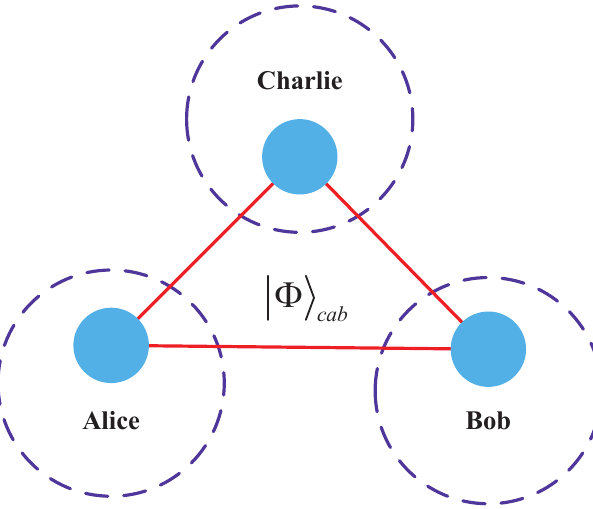
Figure 1. The diagram of scanning radar for aircraft Fig. 1. Particle distribution in one qubit CRSP.